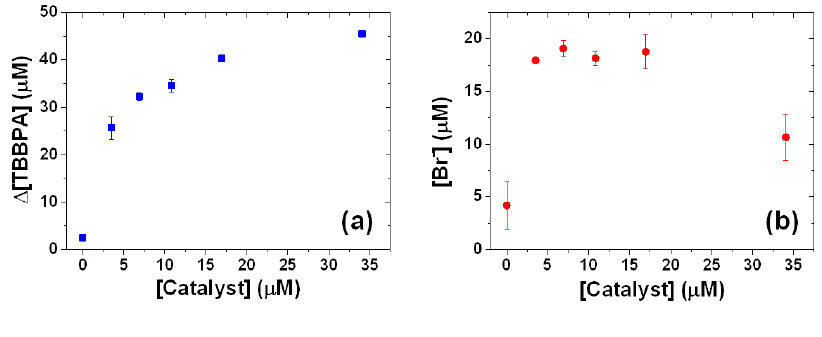
Figure 5. Influence of FeTPPS/IPS concentration on the ( a ) degradation and ( b ) debromination of TBBPA. [TBBPA] 25 °C; reaction time, 35 min. The FeTPPS/IPS concentration at 0.3 g L −1 corresponds to 10  M.